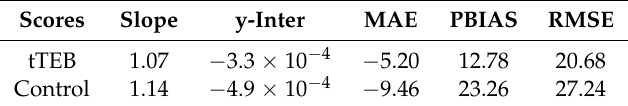
Table 7. Statistical quantities to evaluate the performance of rainfall estimates by tTEB and control experiments against observed rainfall of pluviometric stations of Center for Monitoring and Alerts of Natural Disasters